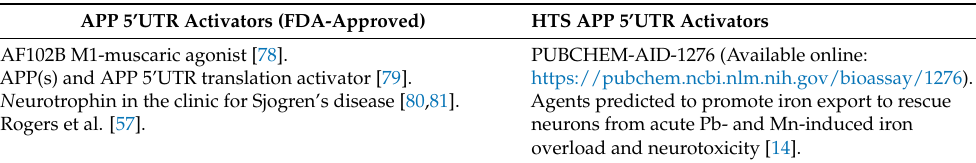
Table 2. Small molecules that activate APP translation to shield neurons from metal toxicity. Therapeutic potential of both FDA-approved and high throughput screened (HTS) translation activators of APP mRNAs to impact an acute iron overload and associated peroxidative redox stress to heavy metal exposed neurons. Left Panel: AF102B is an alpha-secretase activator and neurotrophin clinically employed to treat Sjogren’s disease [78]. This M1 muscarinic agonist was found to also increase APP 5’UTR dependent translation of an APP luciferase reporter gene (Figure 2). Right Panel: PUBCHEM Link of Top high throughput screened (HTS) APP 5’UTR directed activators that were identified based on our transfection-based HTSs (Columbia